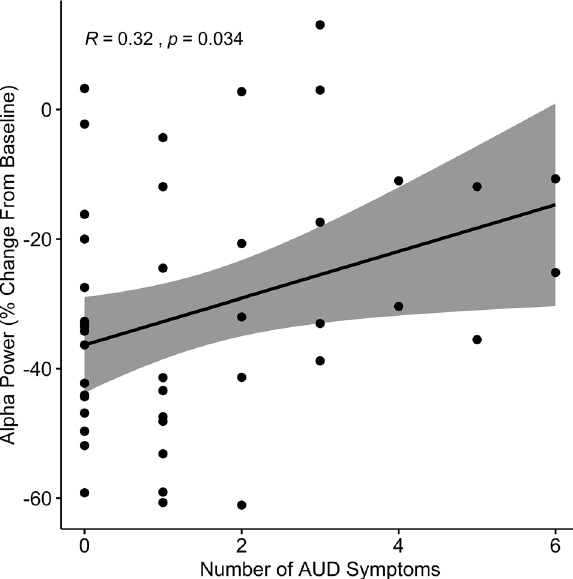
Figure 3. Spearman correlation between alpha power and number of AUD symptoms. Post-hoc testing of alpha power showed a significant correlation between number of AUD symptoms and alpha power such that participants that had more severe AUD exhibited weaker alpha responses. This relationship remained significant in a larger regression model that included number of CUD symptoms, and metrics of cannabis and alcohol consumption, showing that decreased alpha responses are associated with more severe AUD, above and beyond amount of alcohol consumption and cannabis consumption/use disorder. Note that more negative alpha power indicates a stronger alpha response (larger change from baseline). Shaded area represents 95% confidence